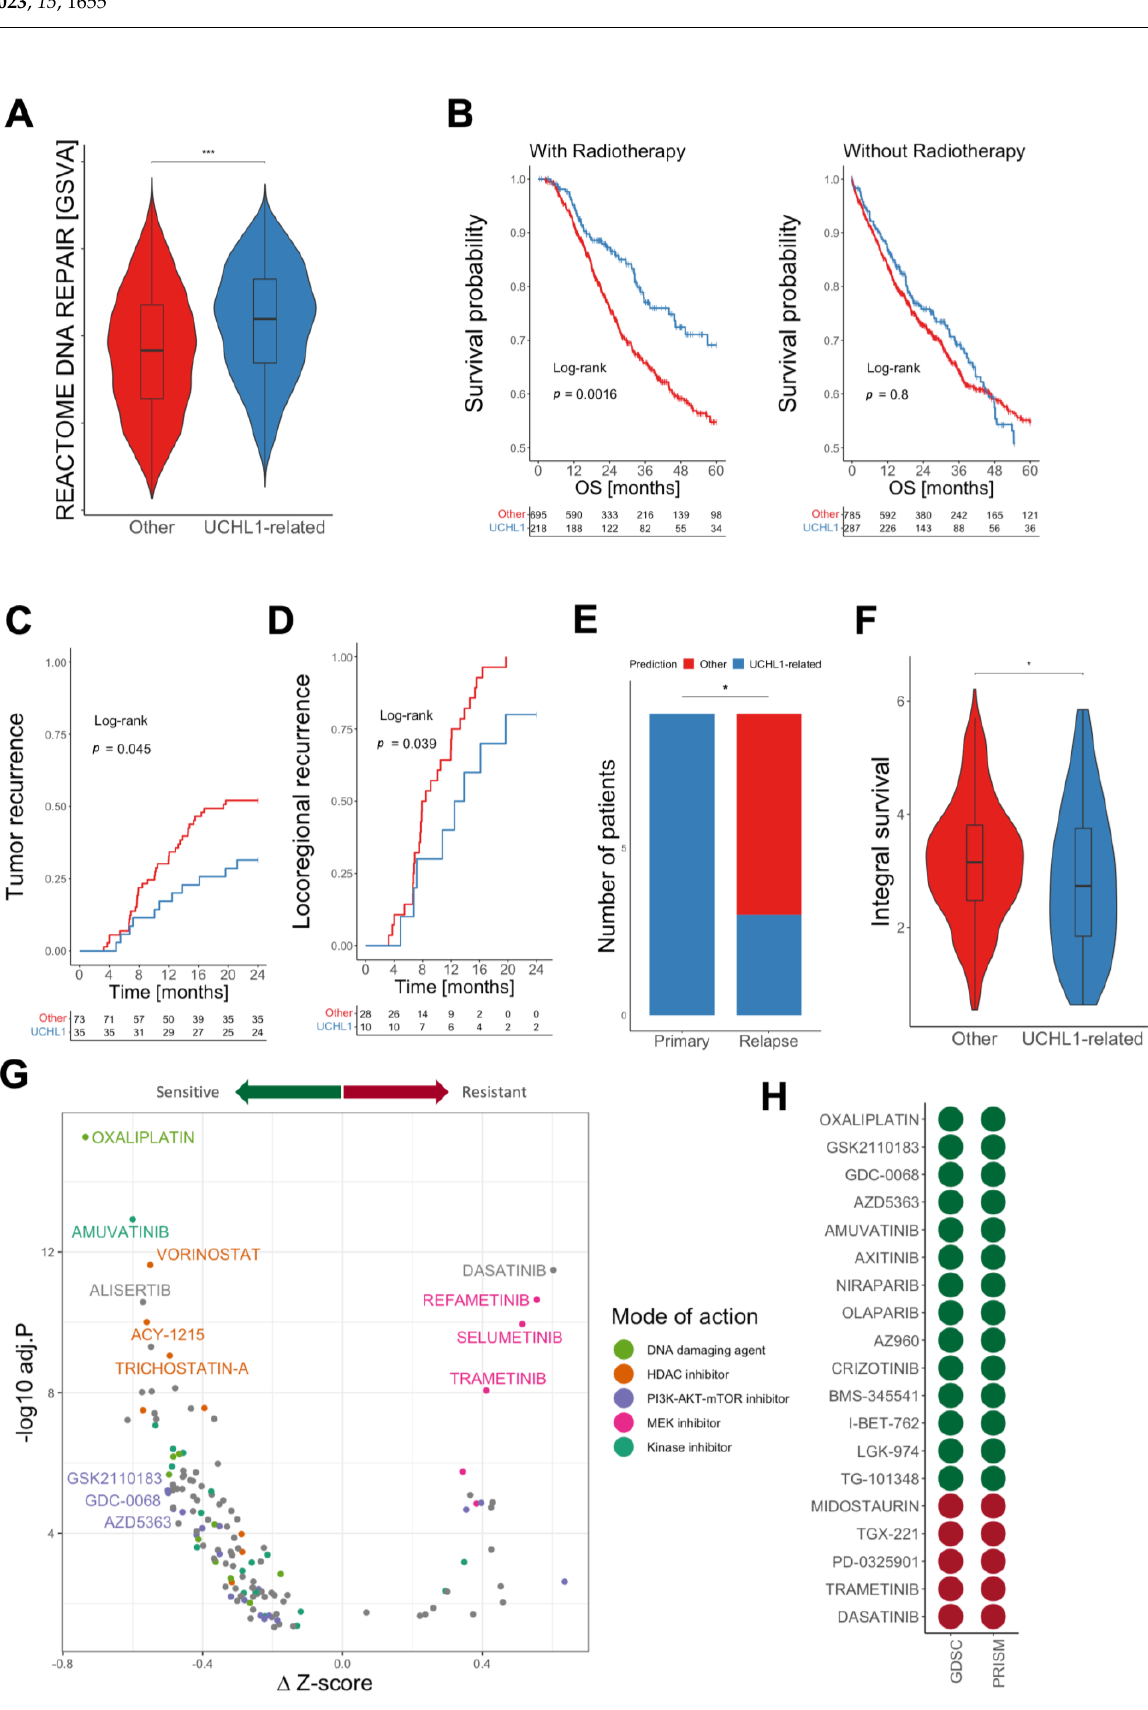
Figure 4. Identification of vulnerabilities for UCHL1-related tumors. ( A ) Violin plot demonstrates significantly higher GSVA scores of the REACTOME DNA REPAIR gene set for UCHL1-related